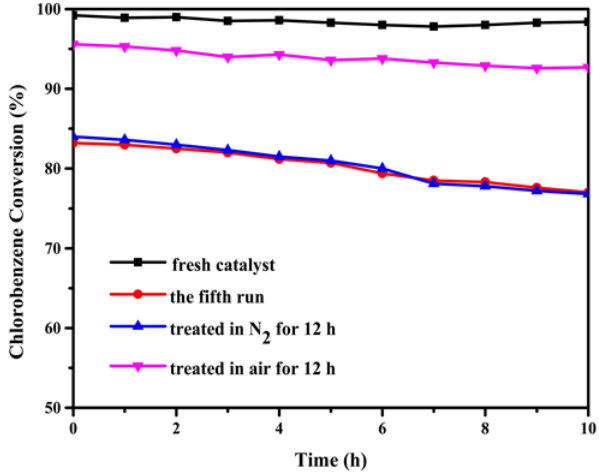
Figure 11. The catalytic efficiency of the MCZ-0.67 catalyst treated under different conditions; activity test condition: 300 °C for 10 h; gas composition: 1000 ppm CB, 21% O 2 ; GHSV = 20,000 h − 1 . test condition: 300 ◦ C for 10 h; gas composition: 1000 ppm CB, 21% O